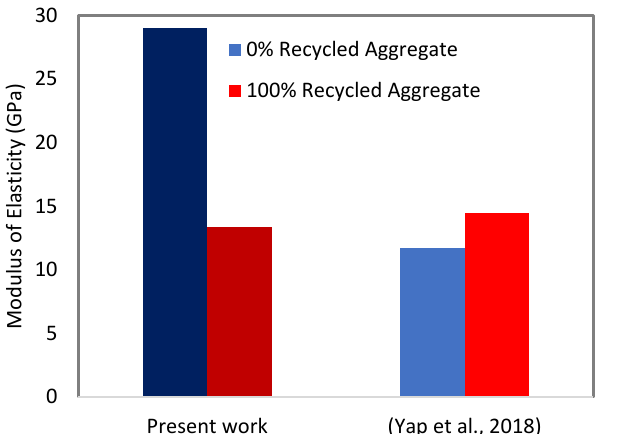
Figure 13. Comparison between the modulus of elasticity values obtained in this study and in the literature.